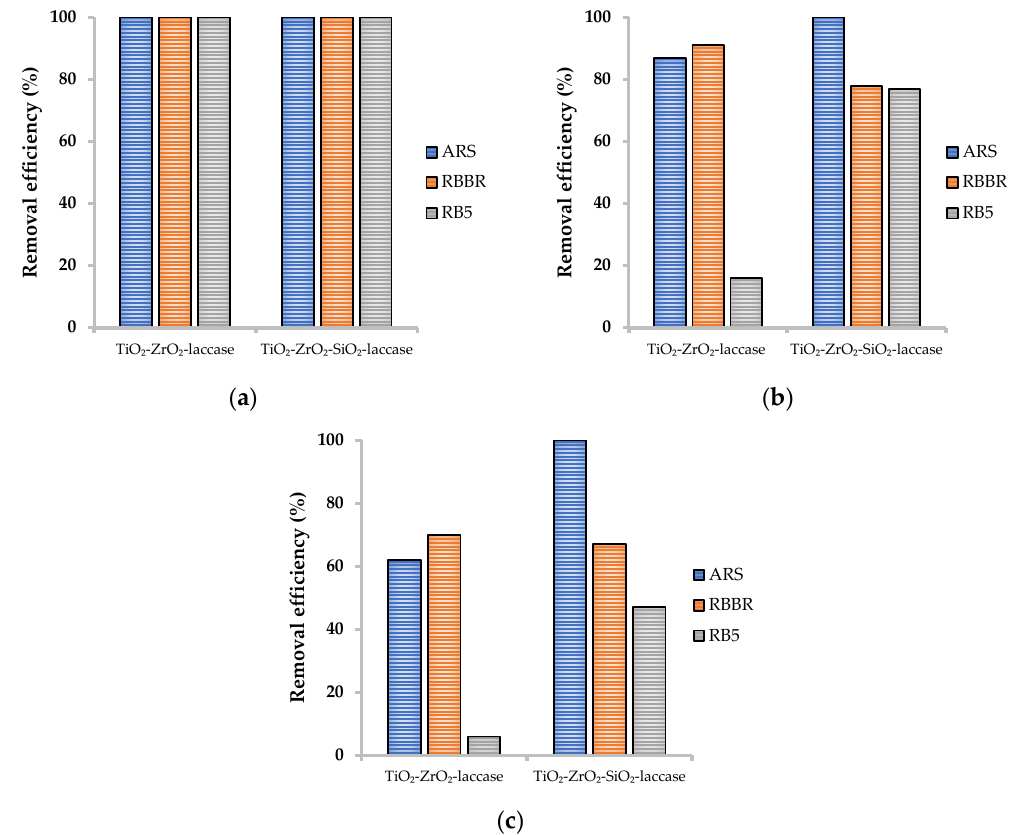
Figure 5. Effect of concentration of ARS, RBBR, an RB5 solutions at concentrations: ( a ) 1 mg/L; ( b ) 5 mg/L; ( c ) 10 mg/L, on its removal efficiencies. The errors of all measurements do not exceed 5%.